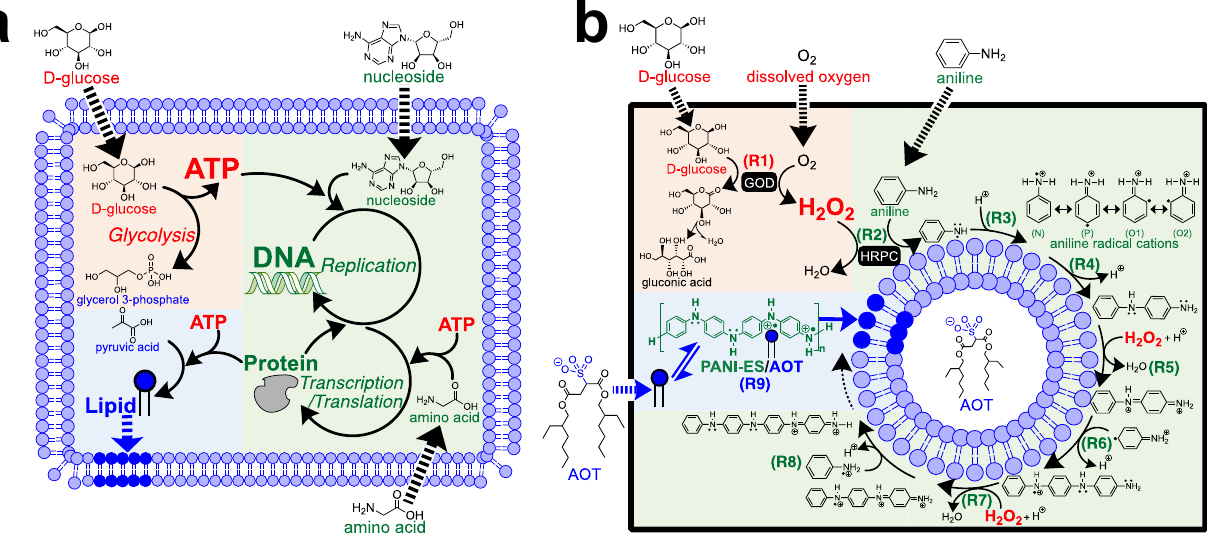
Fig. 1 Simpli fi ed chemical schemes of the essential metabolic transformations in a contemporary living system and in the synthetic minimal cell system presented in this work. a Deduced essential metabolic pathways of a contemporary living system consisting of three elementary units; energy production (orange), processing of genetic information (green), and synthesis of membrane molecules (blue). Black dashed arrows represent the in fl ow of ingredients through the membrane, and the blue dashed arrow indicates the incorporation of synthesised lipids into the membrane. Such simpli fi ed chemical schemes have been also proposed by others 2 – 4 . b Chemical scheme of the arti fi cial metabolic pathways of our synthetic minimal cell consisting of three elementary units; energy production (orange), synthesis of information polymer (green), and membrane growth (blue). The black dashed arrows towards the inside of the thick rectangle represent the reactants (ingredients) supplied close to the vesicles. Membrane molecules (AOT) are also supplied close to the vesicles (blue dashed arrow), being incorporated into the membrane through PANI-ES (blue paired harpoons). For the detailed reaction steps, (R1) – (R9), and the reaction conditions, see Supplementary Note 1 and Materials & Methods ,